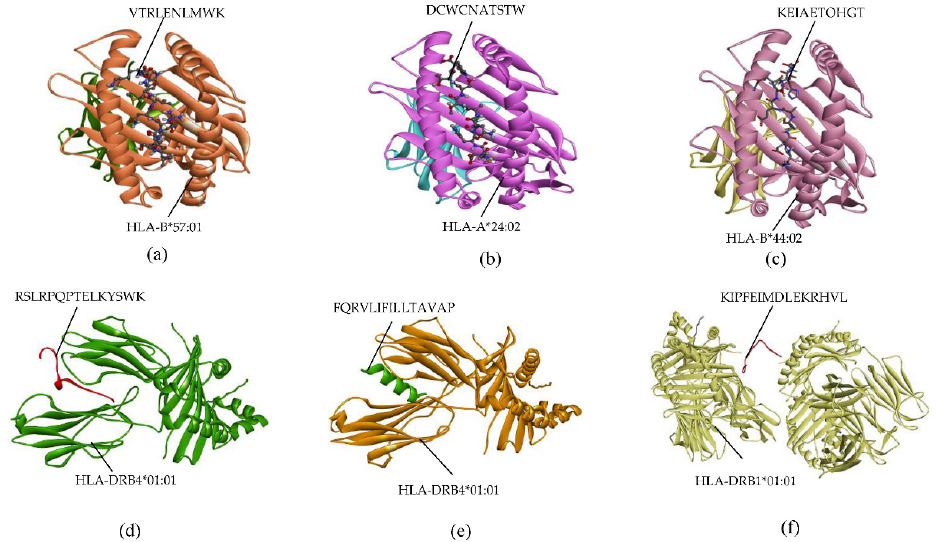
Figure 5. Graphical illustration of docking of epitopes with their corresponding MHC alleles. ( a ) Epitope VTRLENLMWK with HLA-B*57:01. ( b ) Epitope DCWCNATSTW and HLA-A*24:02. ( c ) Epitope KEIAETQHGT and HLA-B*44:02. ( d ) Epitope RSLRPQPTELKYSWK with HLA- DRB4*01:01. ( e ) Epitope FQRVLIFILLTAVAP and HLA-DRB4*01:01. ( f ) Epitope KIPFEIMDLEKRHVL and DC-SIGN, mannose-binding receptor (MR), TLR3, and TLR4, and results were analyzed by PDBsum and visualized by Discovery studio. PDBsum results (Supplementary Figure S7) showed that there were 23 interface residues, 2 salt bridges, 13 hydrogen bonds, and 200 non-bonded contacts between the NS1 protein and DC-SIGN. The number of interface residues between NS1 protein and MR receptor were 26 and 23, respectively, with 10 hy- drogen bonds and 160 non-bonded contacts between them. In total, 50 interface residues were observed between the NS1 protein and TLR3 receptor, with 10 salt bridges, 23 hy- drogen bonds, and 284 non-bonded interactions. The interactions between 27 interface residues of the TLR4 receptor and 30 interface residues of the NS1 protein were supported by 14 hydrogen bonds and 158 non-bonded contacts. Discovery studio revealed that NS1 had nine favorable interactions with each receptor. PDBsum showed that there were 22 interface residues of DC-SIGN interacting with 30 residues of the prM protein, and there were 1 salt bridge, 12 hydrogen bonds, and 194 non-bonded contacts between them. The number of interface residues between the MR receptor and prM protein were 28 and 29, respectively, with 5 salt bridges, 11 hydrogen bonds, and 207 non-bonded contacts. The number of interface residues observed between TLR3 and the prM protein were 30 and 27, respectively, and there were 2 salt bridges, 13 hydrogen bonds, and 242 non-bonded interactions. The interactions between 40 interface residues of the TLR4 receptor and 38 interface residues of the prM protein were supported by 10 salt bridges, 20 hydrogen bonds, and 273 non-bonded interactions. Discovery studio showed that prM also had nine favorable interactions with DC-SIGN, MR, and the TLR4 receptor and eight favorable interactions with TLR3. Sixteen interface residues of both DC-SIGN and the EIII protein interacted with each other, and 1 salt bridge, 7 hydrogen bonds, and 120 non-bonded contacts were observed between them. EIII and MR receptors showed 14 and 19 interacting interface residues, respectively, and 2 salt bridges, 10 hydrogen bonds, and 146 non-bonded contacts were